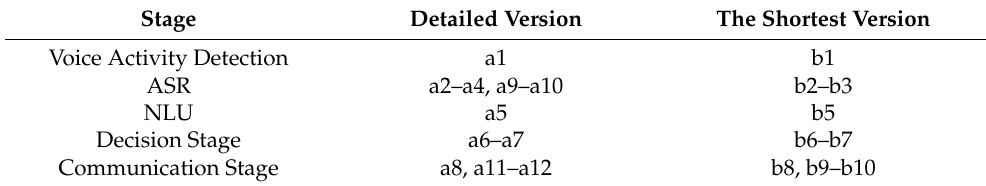
Table 1. Description of voice-controlled dialog in a smart home system (in two versions; a more detailed and the shortest